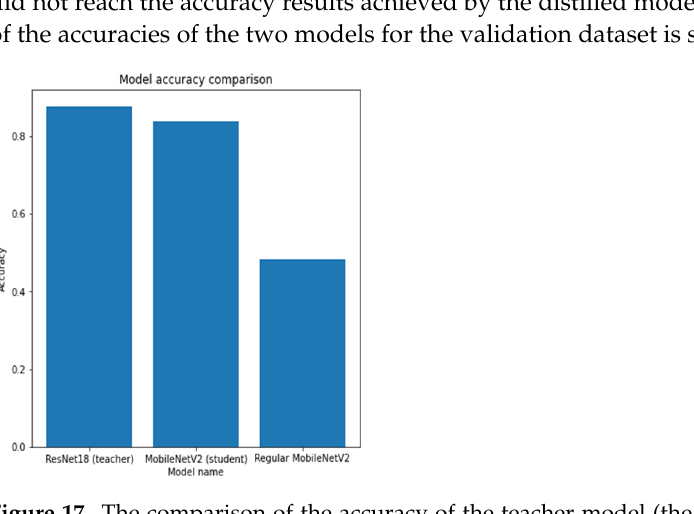
Figure 16. The accuracy of the model for the validation datasets obtained during the regular training of the model.